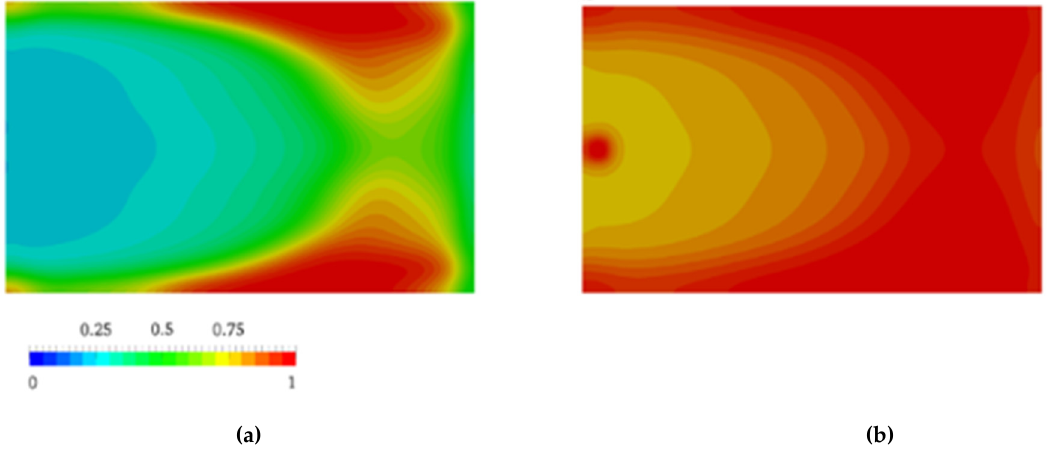
Figure 12. The distribution of polymer conversion β at: ( a ) t = 20.0 s; ( b ) t = 40.0 s. [105], reproduced with copyright permission from Elsevier, 2014.